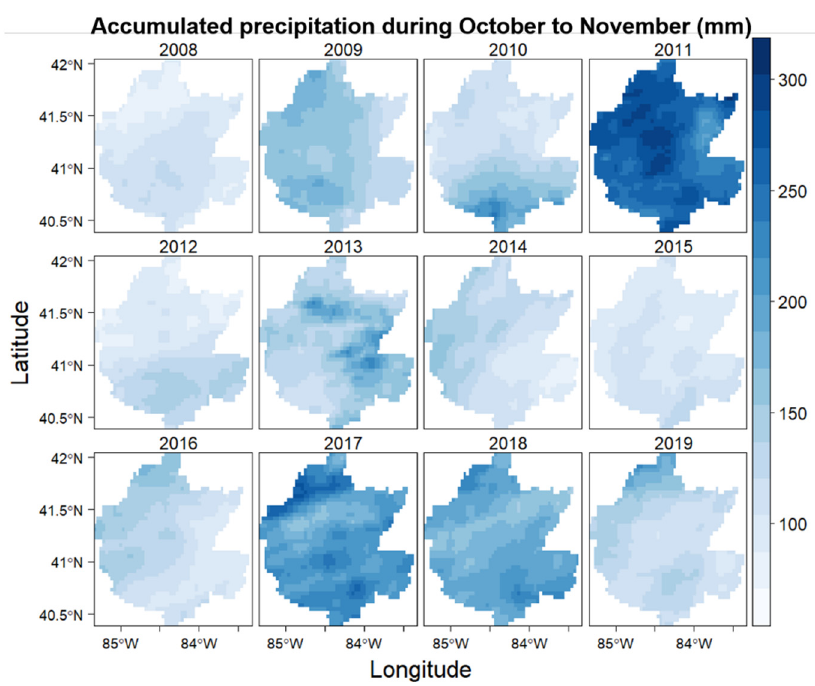
Figure 9. Total precipitation for the months of October and November.